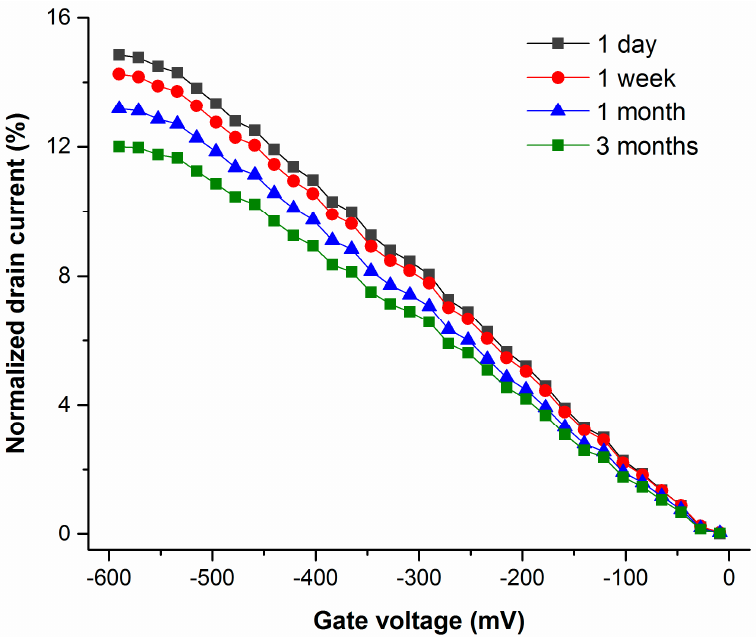
Figure 7. I d vs. V g of devices after storage under ambient conditions for different durations.